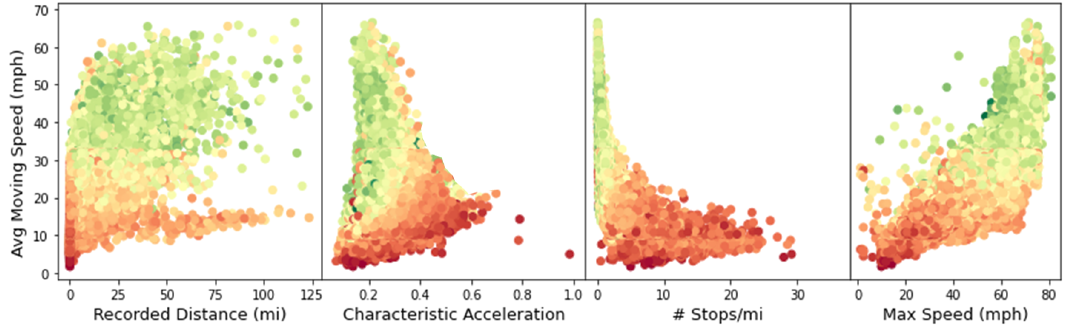
Figure 1. Sample Data across XLFleet trip statistics library. Color is Fuel Efficiency (green is better).